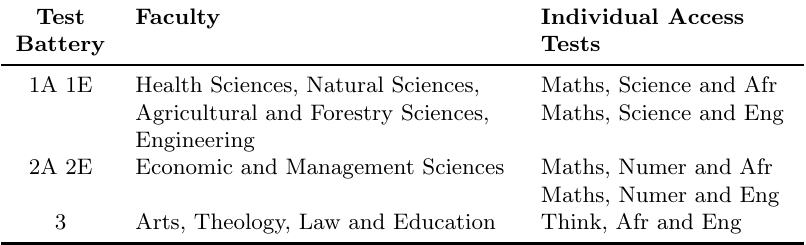
Table 1: Composition of access test